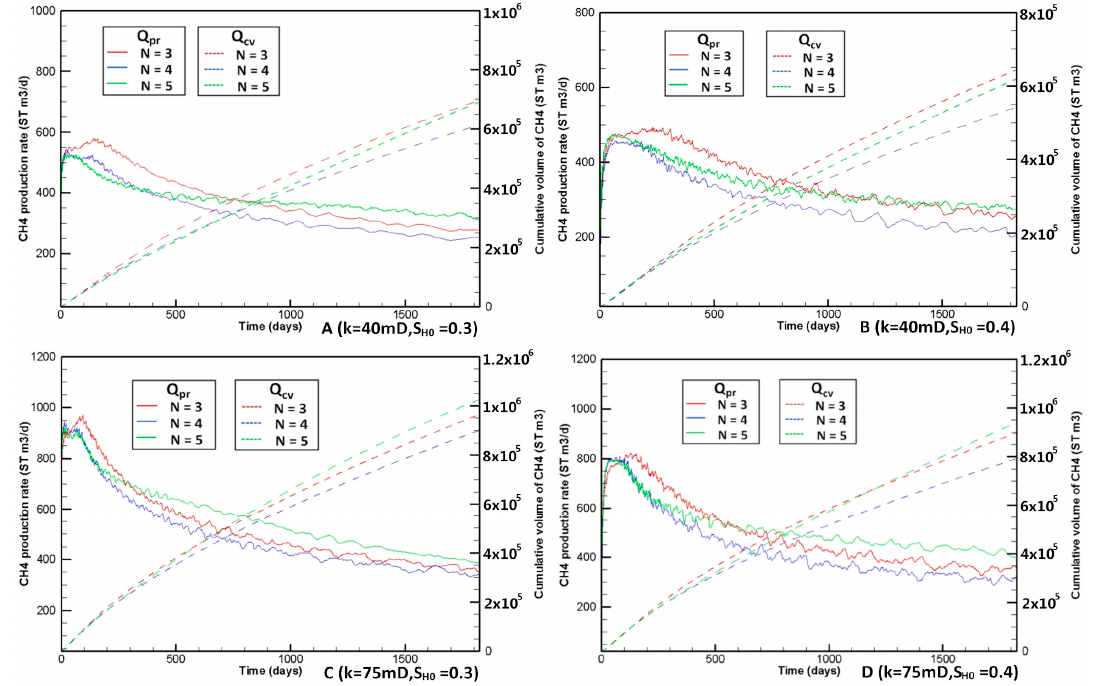
Figure 5. Q pr and Q cv from NGH deposit in the Shenhu area under different accumulation conditions for different N values ( N = 3, 4, and 5). ( A ) k = 40 mD, S H 0 = 0.3; ( B ) k = 40 mD, S H 0 = 0.4; ( C ) k = 75 mD, S H 0 = 0.3; ( D ) k = 75 mD, S H 0 = 0.4.